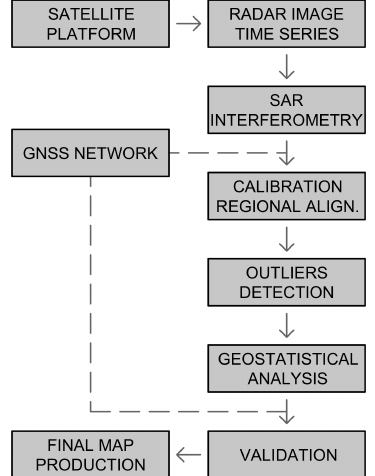
Figure 1. The workflow from data acquisition to final map produc-